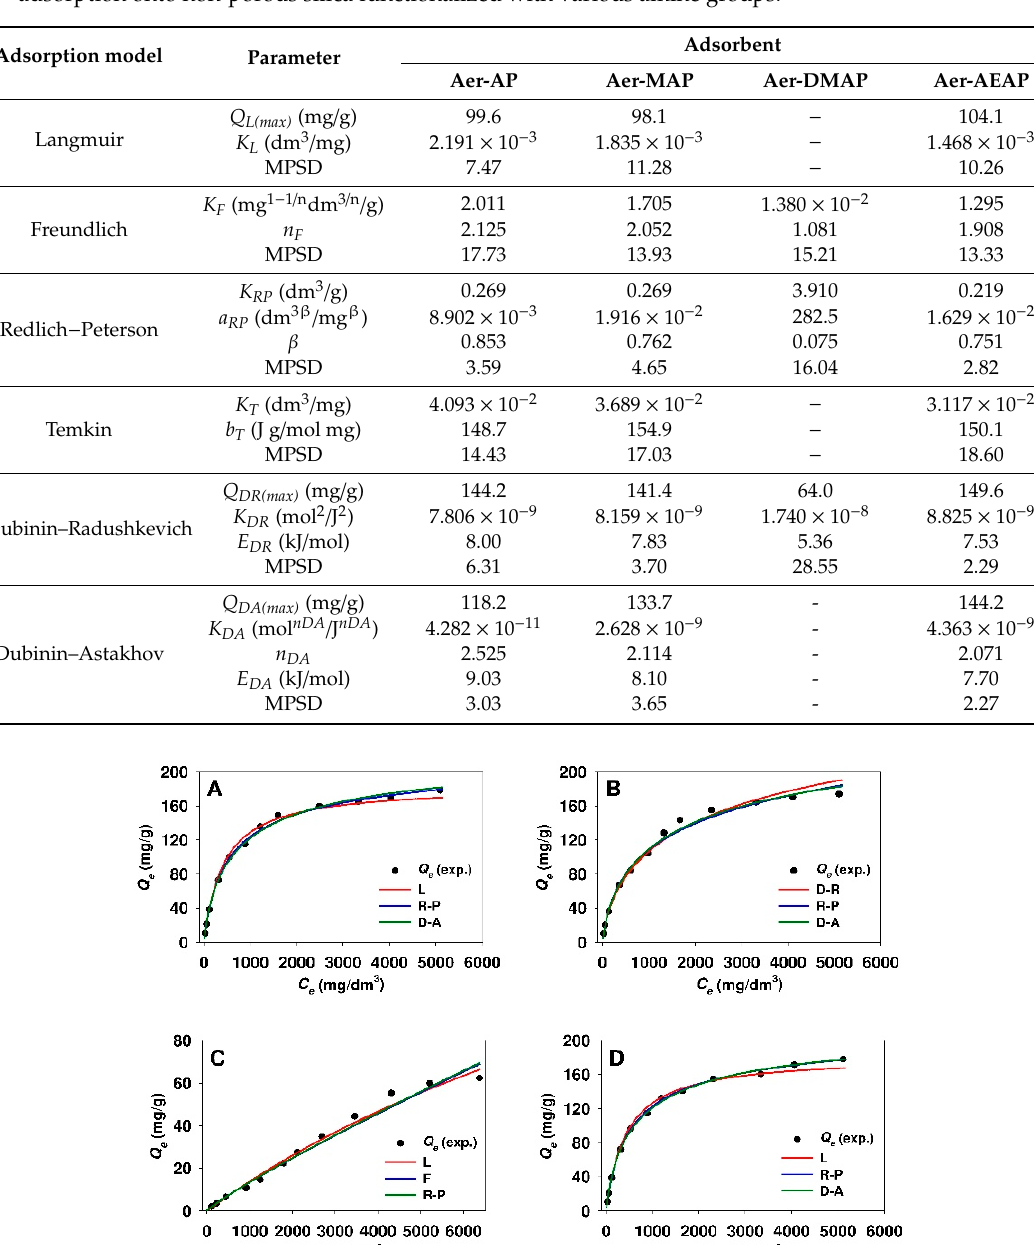
Figure 13. Comparison of experimental and predicted isotherms of 18 β -glycyrrhetinic acid adsorption onto ( A ) Aer-AP, ( B ) Aer-MAP, ( C ) Aer-DMAP, and ( D ) Aer-AEAP adsorbents. The best fitted isotherm models derived from nonlinear fitting analysis are presented. Isotherm models: F, Freundlich; D-A, Dubinin-Astakhov; D-R, Dubinin-Radushkevich; R-P, Redlich-Peterson.